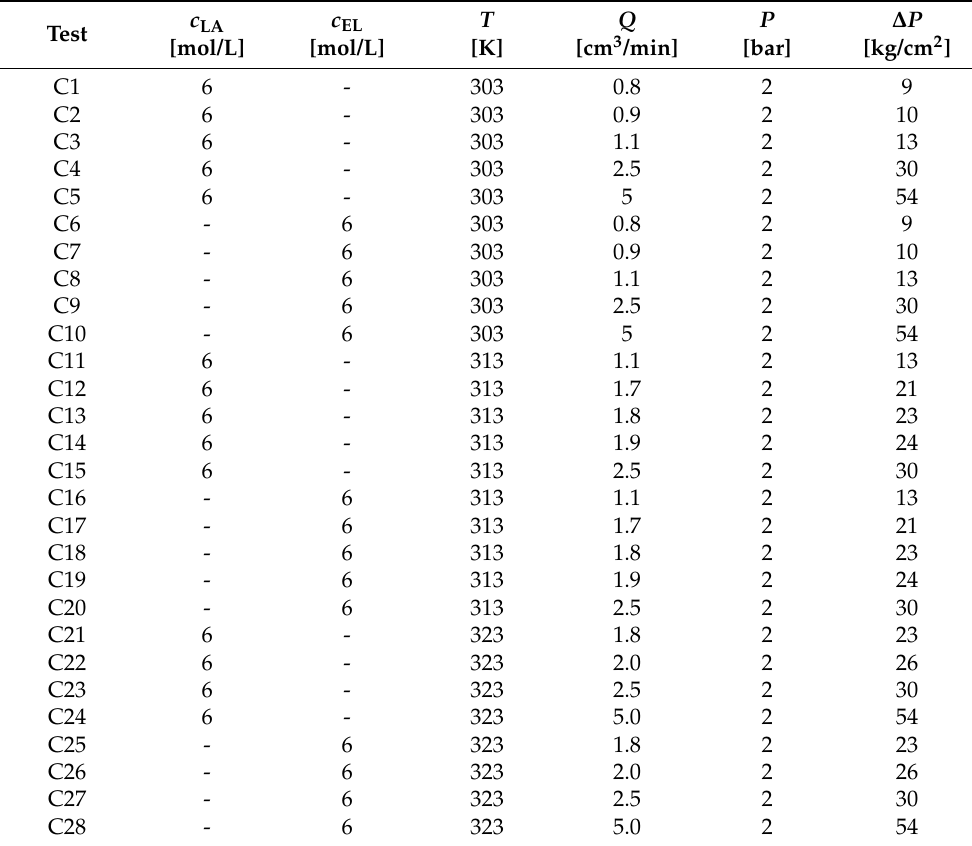
Table 2. Experimental conditions for the chromatographic reactor